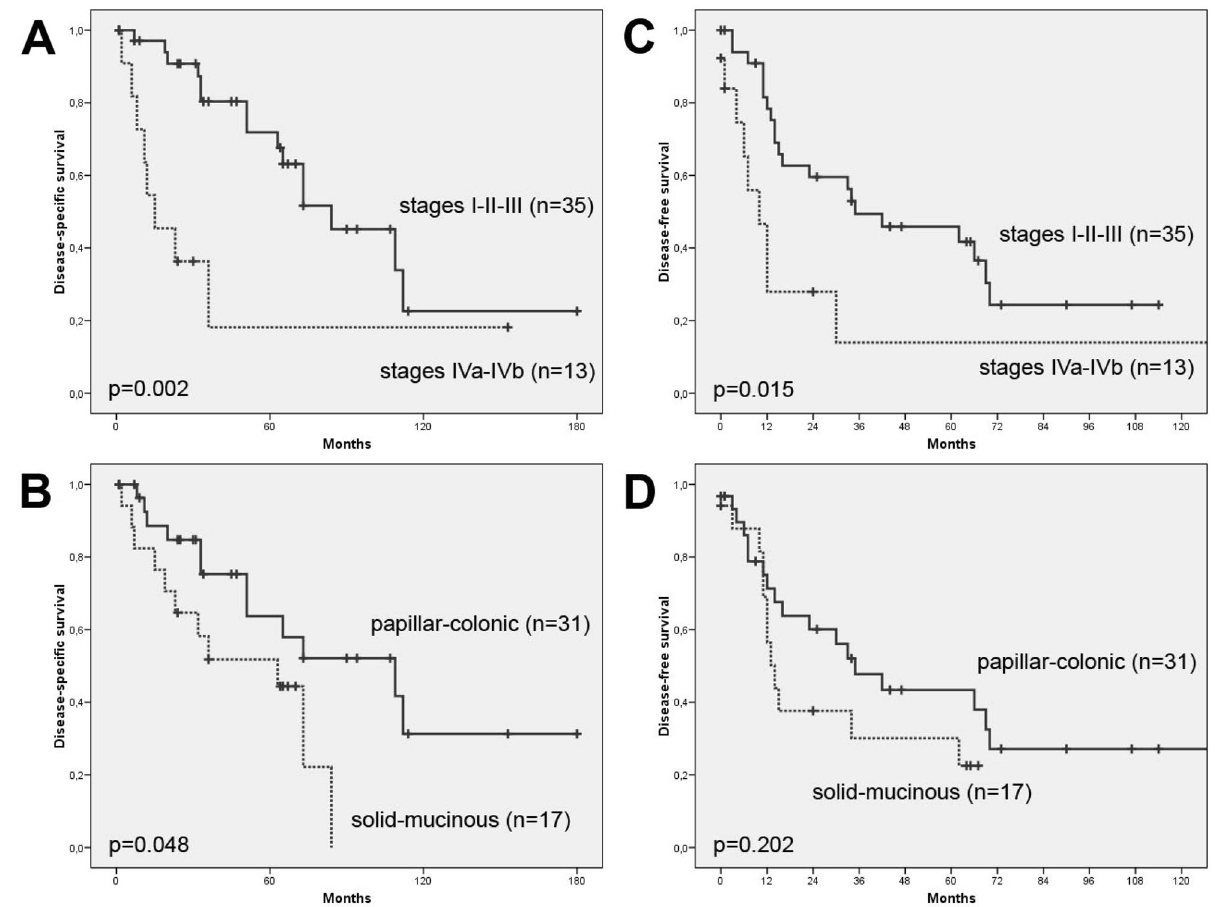
Figure 1. Disease-specific survival according to ( A ) tumor stage (I/II/III versus IVa/IVb) and to B ) histological subtype (papilar/colonic versus solid/mucinous). Disease-free survival according to ( C ) tumor stage (I/II/III versus IVa/IVb) and to ( D ) histological subtype (papilar/colonic versus